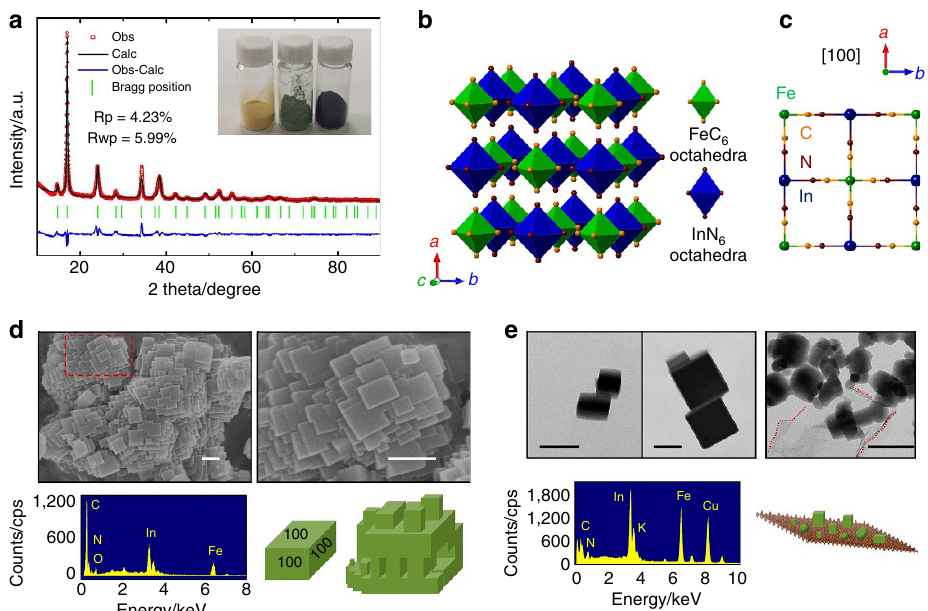
Figure 1 | Cubic InHCF. ( a ) Rietveld refinement of X-ray power diffraction pattern for InHCF with cubic structure. Insets are the photos of fresh InHCF, InHCF after vacuum drying and InHCF/Gr. ( b ) A unit cell of cubic InHCF with a formula of InFe(CN) 6 . ( c ) Ball stick pattern of InFe(CN) 6 viewed down the [100] zone axis. ( d ) SEM images of InHCF nanocube with different magnification (top of panel), energy-dispersive X-ray spectroscopy (EDS) of InHCF nanocubes and a schematic of ‘toy bricks’ assembled by InHCF nanocube with six facets of [100] (bottom of panel). Scale bar, 200nm. ( e ) TEM images of InHCF nanocube and InHCF/Gr (top of panel), EDS of InHCF/Gr (bottom of panel) and a schematic of InHCF with irregular shapes deposited on graphene. Scale bar,